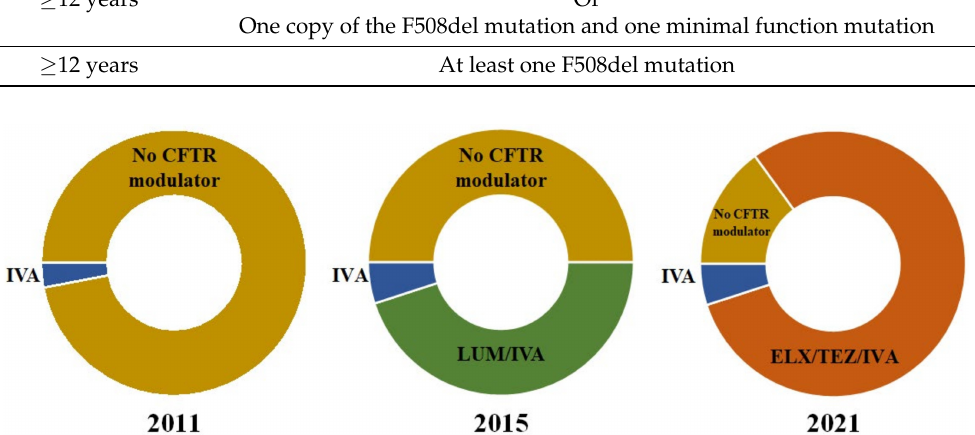
Figure 2. Proportion of the French CF population aged 12 years and older eligible for CFTR modulator therapy in 2011, 2015, and 2021 [20]. In 2011, only 3% of people with CF (pwCF) were eligible to receive a CFTR modulator (ivacaftor). In 2015, with lumacaftor–ivacaftor, half of the patient population became eligible, with 5% eligible for ivacaftor (at least one gating mutation) and 45% for lumacaftor– ivacaftor combination therapy (homozygous for the F508del mutation). By 2021, 82% were eligible for elexacaftor/tezacaftor/ivacaftor (at least one F508del mutation). There are still 10–15% of pwCF who have no access to CFTR modulator therapy. IVA: ivacaftor; LUM: lumacaftor; ELX: elexacaftor; TEZ: